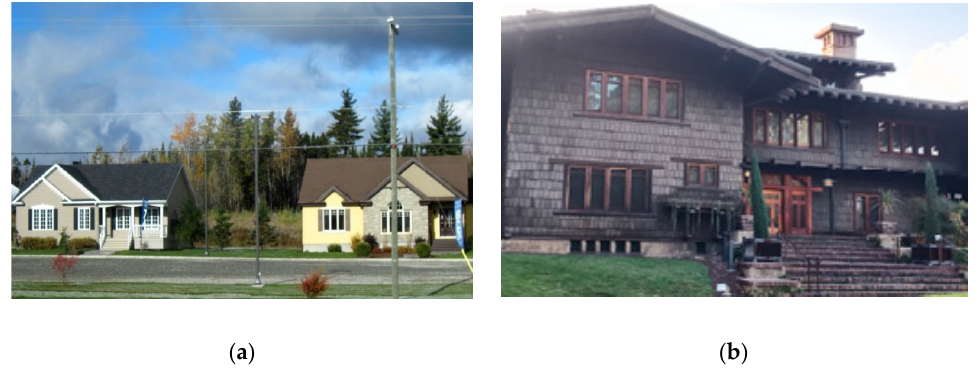
Figure 12. An example of a wooden building according to Canadian technology: ( a ) wooden houses in Canada; ( b ) The Gamble House (Pasedena, California), one of the oldest wooden houses in the USA. Built in 1908, it is currently a house of historical and cultural importance.